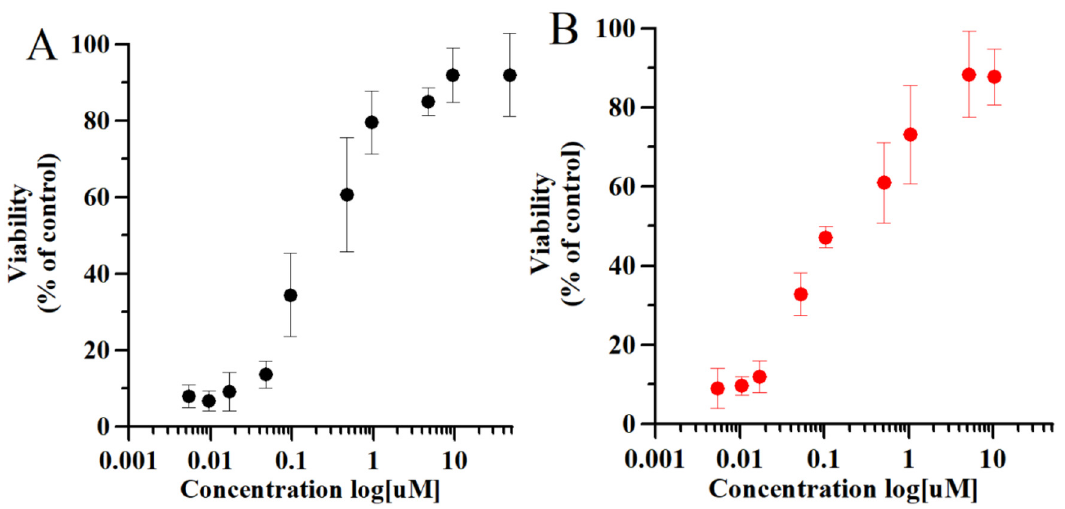
Figure 5. Dose-response relationship for inhibition of erastin-induced (10 µ M, 24 h) death in J774 cells by Fer-1 ( A ) and T β 4 ( B ). Cell viability quantitative data are shown as mean and standard error. Statistical comparison of the cell viability quantitative data in different experimental conditions were performed, with 5.0 GraphPad Prism software, by the unpaired t-test. The data were also analyzed with one-way ANOVA. p values < 0.05 was considered